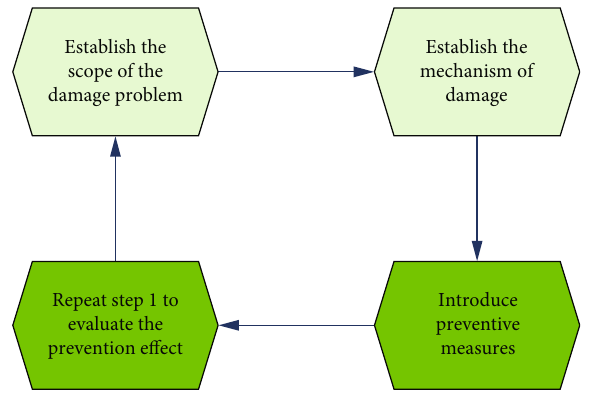
Figure 7: Steps to prevent muscle damage. Table 1: Basic situation of athletes.